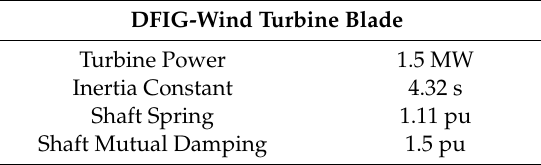
Table A2. Data for DFIG Wind Turbine Blade.